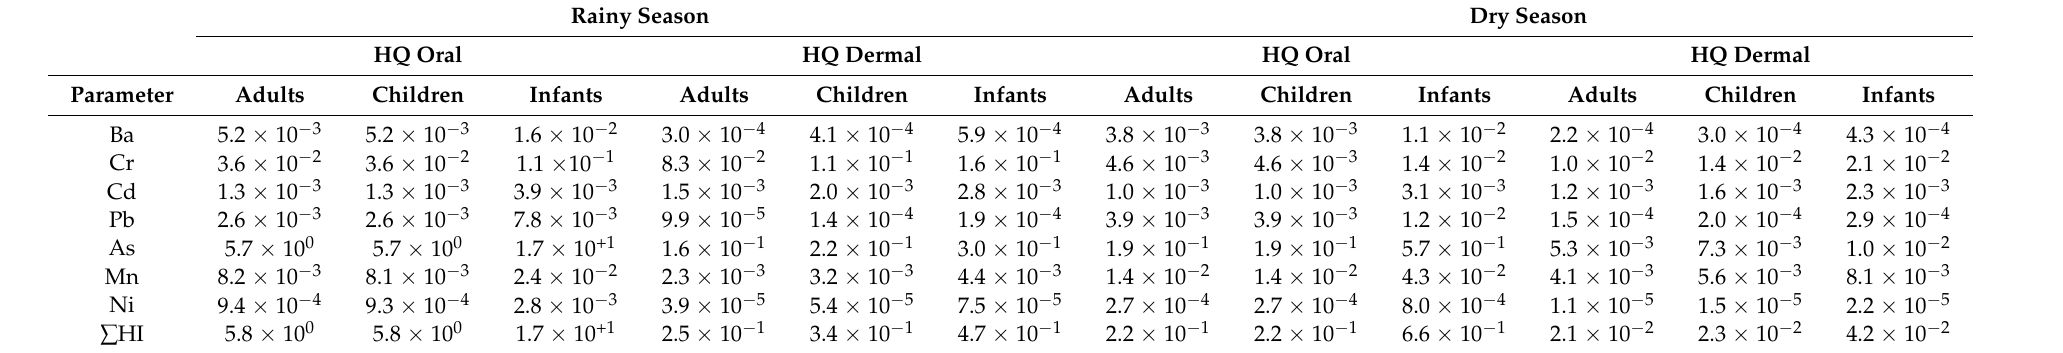
Table 6. Calculated hazard quotients (HQ) due to oral and dermal exposure of metals in water.